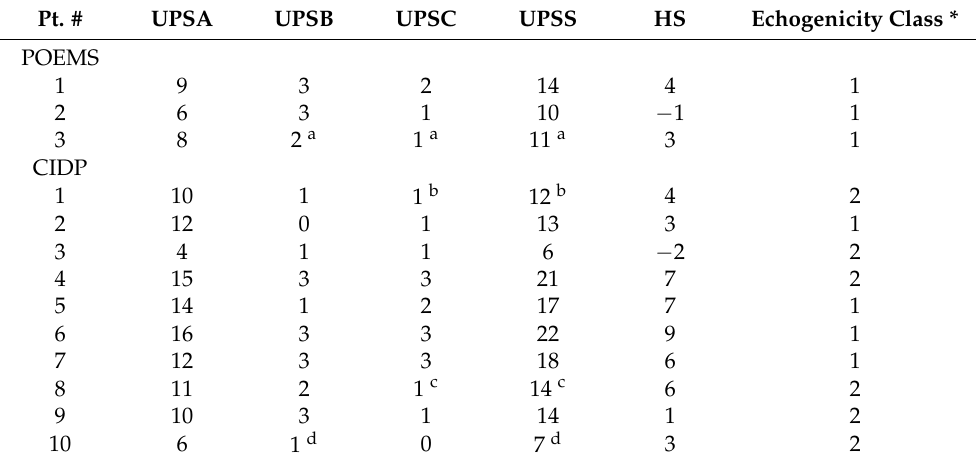
Table 9. UPSA, UPSB, UPSC, UPSS, HS and echogenicity classes for POEMS and CIDP patients. Pt. # UPSA UPSB UPSC UPSS Echogenicity Class